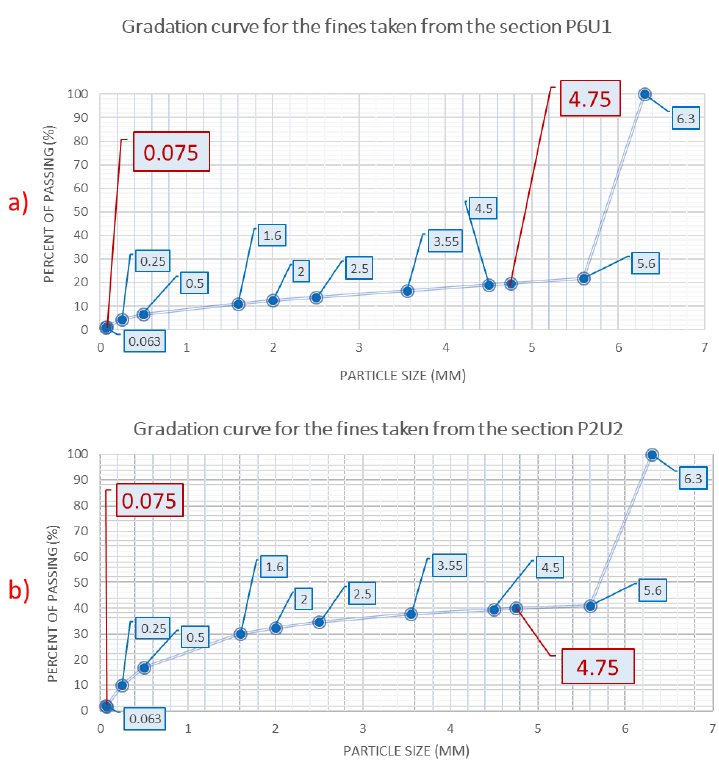
Figure 6. Gradation curves for the finer material extracted from the sections ( a ) P6U1 and ( b ) P2U2.